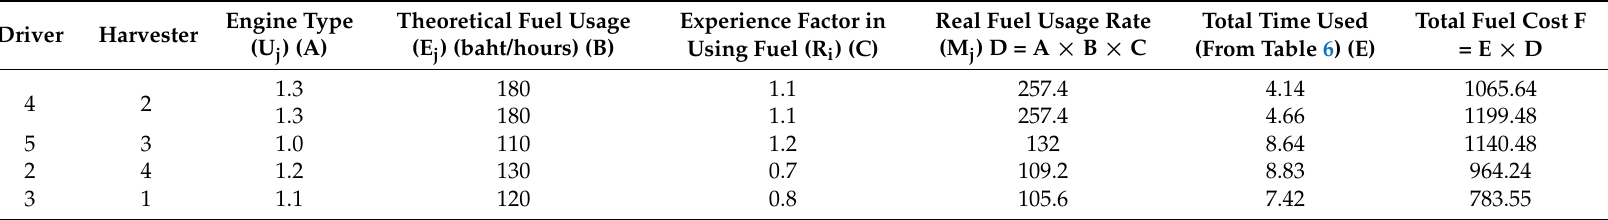
Table 7. Results of calculating the total cost for the